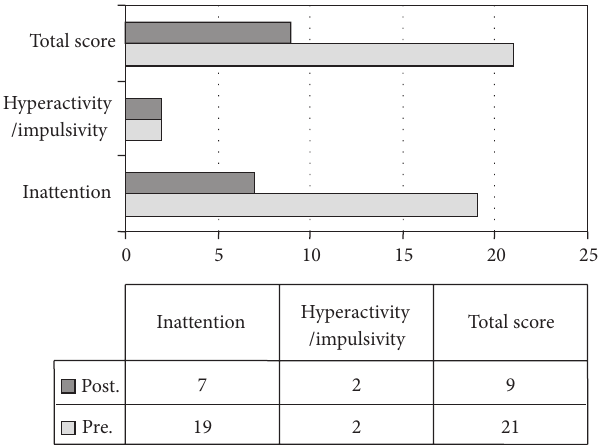
Figure 1: ADHD-RS-IV-Parent:Inv: raw scores in baseline (pre- treatment)andwithMPHtreatment(posttreatment).Thetotalscore improved from 21 ( 𝑀 = 2.22 , SD = 0.97) to 9 ( 𝑀 = 1.00 , SD = 0.71), paired-sample 𝑡 (8) = 5.50; 𝑃 < .001 , one-tail, and Cohen’s 𝑑 = 1.43 .